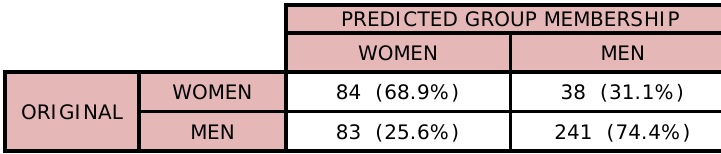
1st axis: this represents the dimension Originality, Innovative and Luxury with the adjectives “original”, “innovative”, “design”, “full of character”, “luxury”, “fashionable”, “delightful” and “not simple”. It explains 8.49% of the variance.